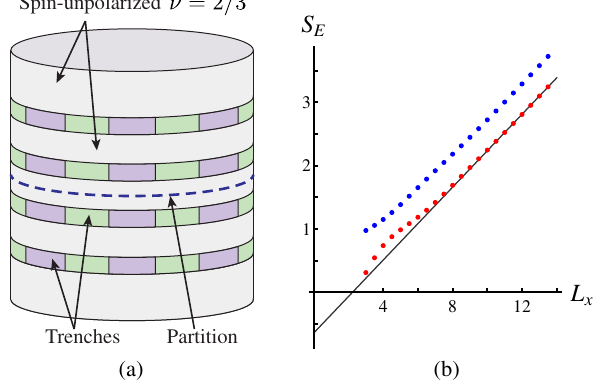
FIG. 8. (a) Bipartition of the superstructure that cuts between two chains on a cylinder. (b) Entanglement entropy S E of the j 1 i (red dots) and j ε i (blue dots) ground states of the 2D Fibonacci phase as a function of the cylinder circumference L x , computed numerically via the truncated conformal space approach. Fitting S 1 i to the form sL − γ at large L E for state j x x , we extract the intercept − γ ≈ − 0 . 65 ; see the solid line in the figure. This yields a total quantum dimension D ≈ 1 . 9 for the Fibonacci phase. Taking the difference S E ½j ε i(cid:1) − S E ½j 1 i(cid:1) ¼ log d ε , we deduce the quantum dimension d ε ≈ 1 . 62 ≈ φ , which confirms that ε corresponds to the Fibonacci